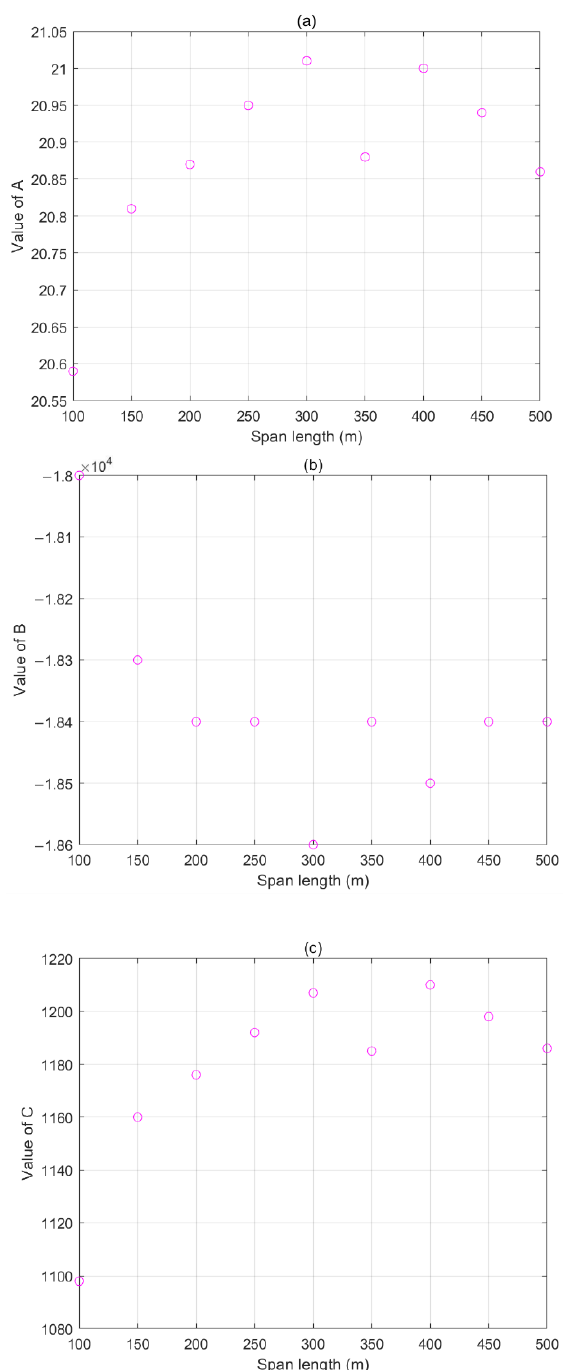
Figure 10. Effects of span length on coefficients: ( a ) A of different span lengths; ( b ) B of different span lengths; ( c ) C of different span lengths.